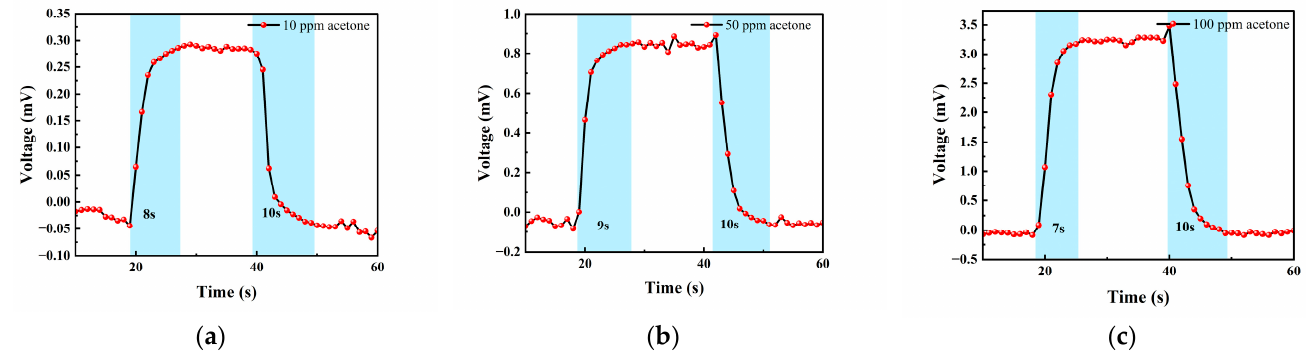
Figure 16. ( a ) 10 ppm acetone gas response–recovery time; ( b ) 50 ppm acetone gas response–recovery time; and ( c ) 100 ppm acetone gas response–recovery time.